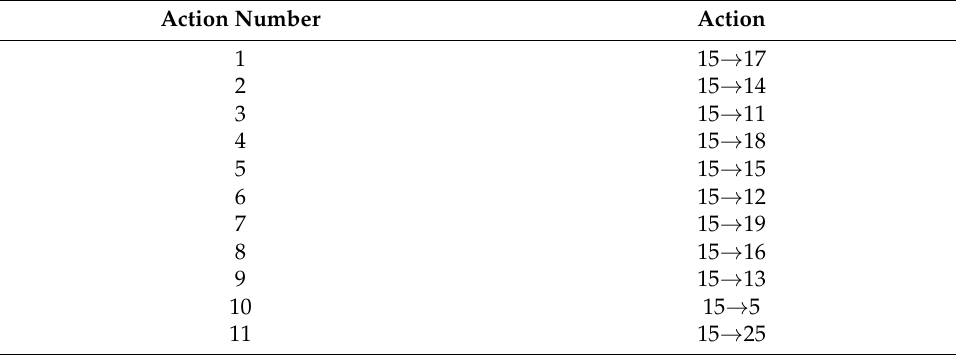
Figure 2. Same as Figure 1, but for the 3D case. Table 1. The action set partitioning in the 3D space.